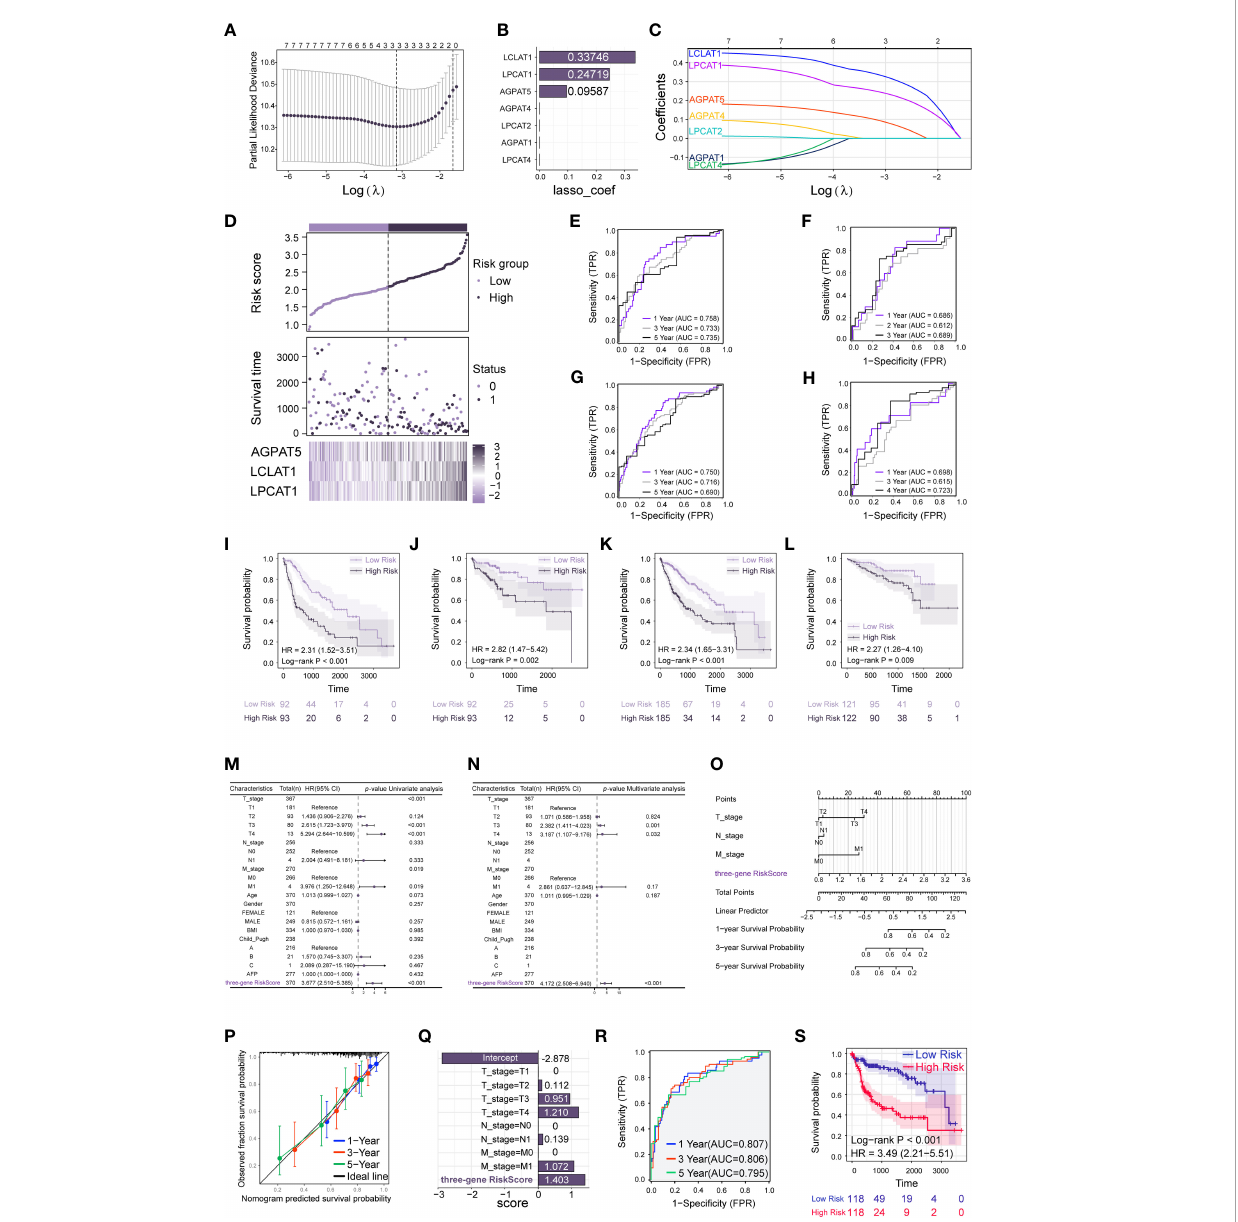
FIGURE 2 Construction and validation of prediction model based on the GPAT / AGPAT gene family. (A, C) LASSO penalized Cox regression was performed to screen out the three best prognosis-related genes. (B) Genes associated with overall survival (OS) and their coef fi cients. (D) Risk score distribution, risk grouping, survival outcome, and molecular expression for the prognostic model in the TCGA-LIHC training set. (E – H) Time-dependent receiver operating characteristic (ROC) analysis to assess the sensitivity and speci fi city of the prognostic model in TCGA training set (E) , validation set (F) , total set (G) , and ICGC-LIRI external validation set (H) . (I – L) Kaplan-Meier survival analysis comparing the differences in survival outcomes between the high-risk and low-risk groups in TCGA training set (I) , validation set (J) , total set (K) , and ICGC-LIRI external validation set (L) . (M, N) Univariate and multivariate Cox regression analysis identi fi ed the risk score as an independent prognostic factor when clinical variables were included. (O) A Cox model-based nomogram for predicting 1 – 5-year overall survival (OS). (P) Calibration curves of the nomogram in the overall set for predicting 1 – 5-year OS. (Q) Coef fi cients were obtained for each variable based on the results of the multivariable Cox model integrating the clinical variables and the three-gene risk score. (R, S) Time-dependent receiver operating characteristic (ROC) analysis (R) and Kaplan-Meier survival analysis (S) was performed based on the median grouping of the new risk scores for each